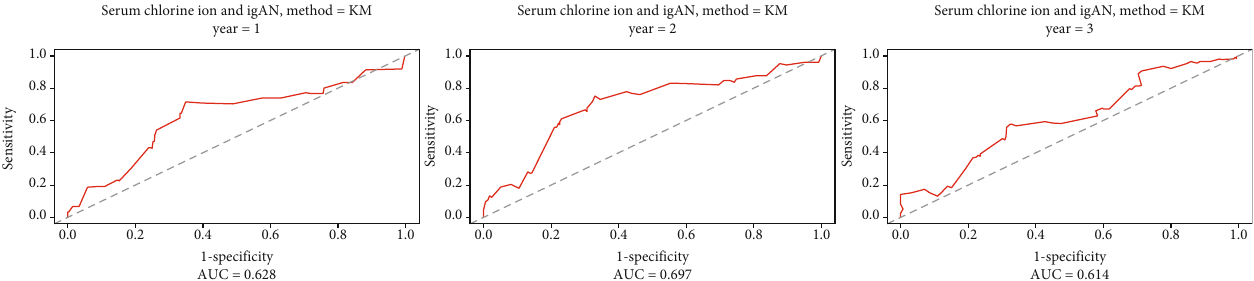
Figure 1: Survival receiver operating characteristic (ROC) curves for 1-, 3-, and 3-year survival. The areas under the receiver operating characteristics curves (AUCs) were 0.63, 0.70, and 0.61 for 1-, 2-, and 3-year follow-up, respectively. The cut-o ff values were 105.50 for 1-year follow-up and 105.40 for 2- and 3- ear